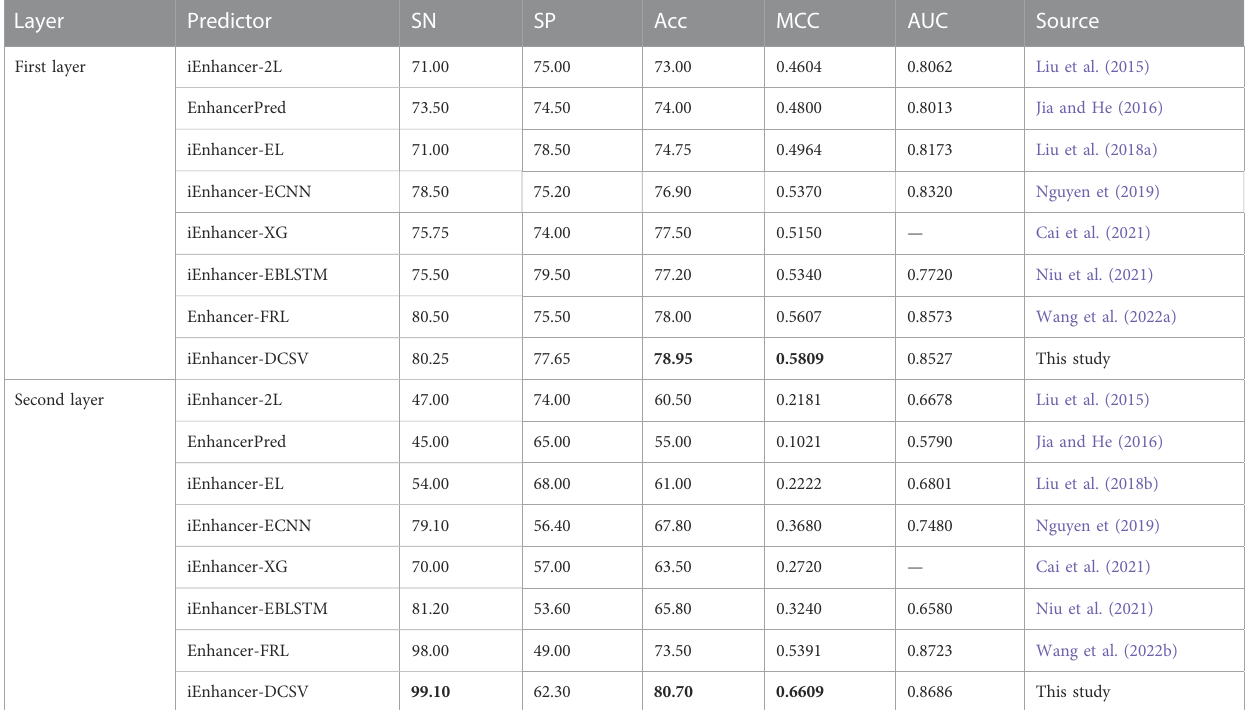
TABLE 6 Comparison with other methods on the same independent